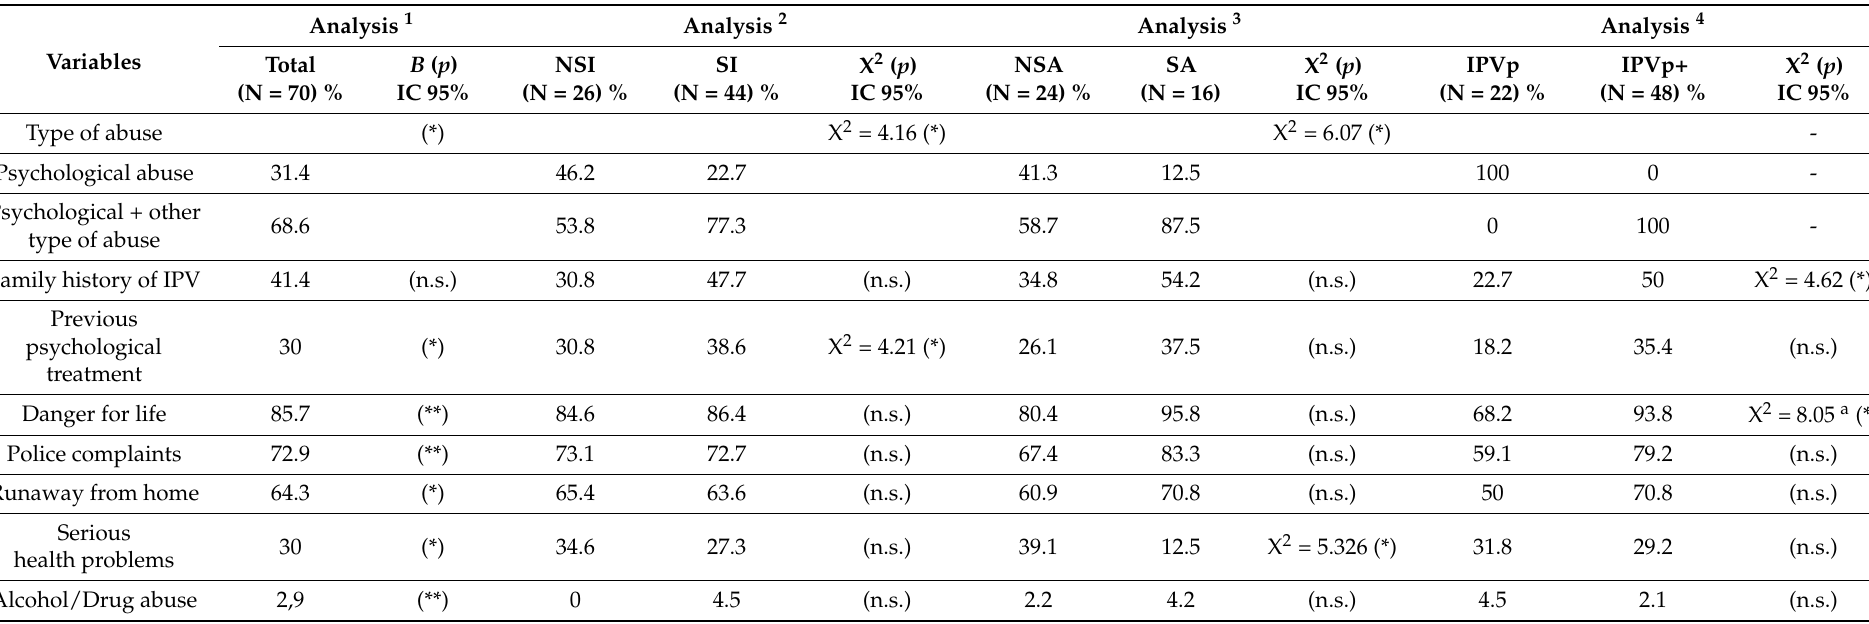
Table 2. Qualitative analysis of the experience of gender abuse according to the suicidal behaviour and type of